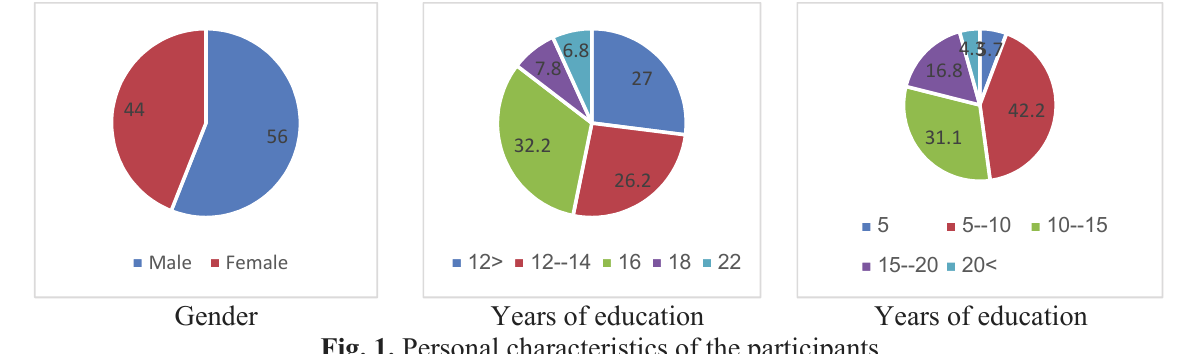
Fig. 1. Personal characteristics of the participants The results principle component analysis Component Initial Eigenvalues Extraction Sums of Squared Loadings Rotation Sums of Squared Loadings Total % of Variance Cumulative %